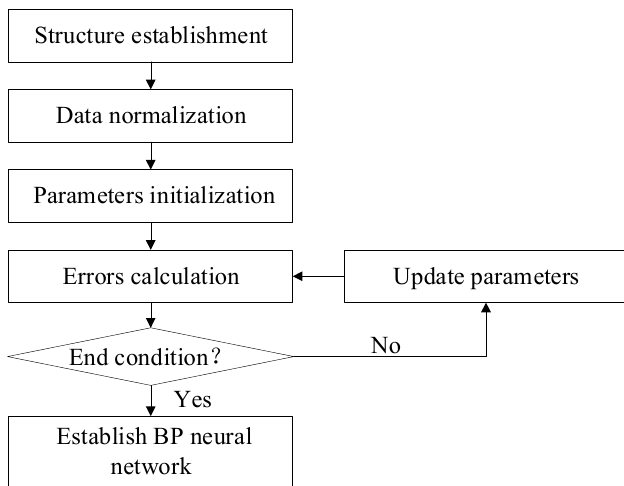
Figure 4. Flowchart of the BP neural network.